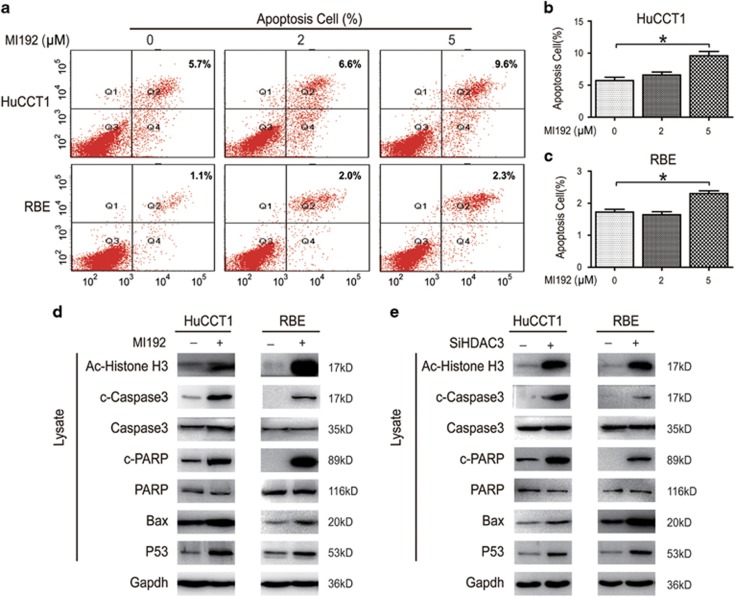
MI192-induced CCA cell apoptosis in vitro. (a) Cells were treated with MI192, and cell apoptosis was analyzed via flow cytometry. (b and c) Cell apoptosis was quantified. (d and e) Cells were collected and subjected to western blot after MI192 treatment (left) and small interfering RNA (siRNA) transfection (right); *P<0.05